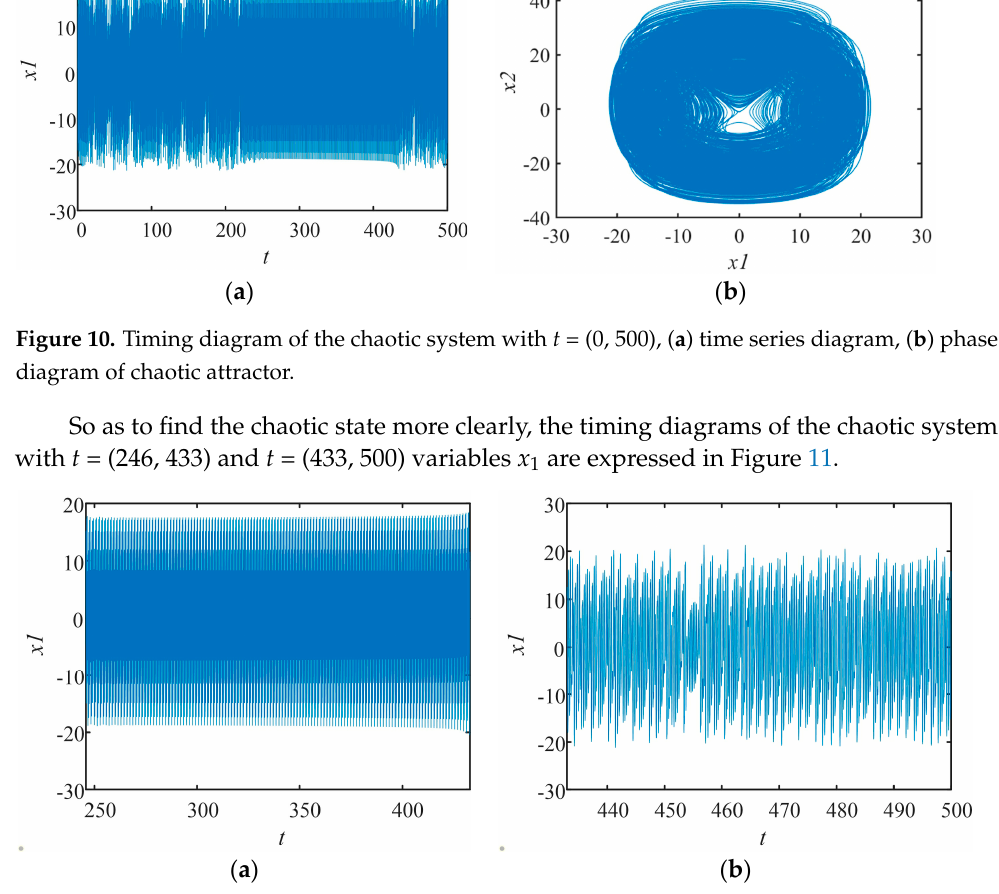
Figure 11. Timing diagram of the chaotic system, ( a ) t ∊ (246, 433), ( b ) t ∊ (433, 500).